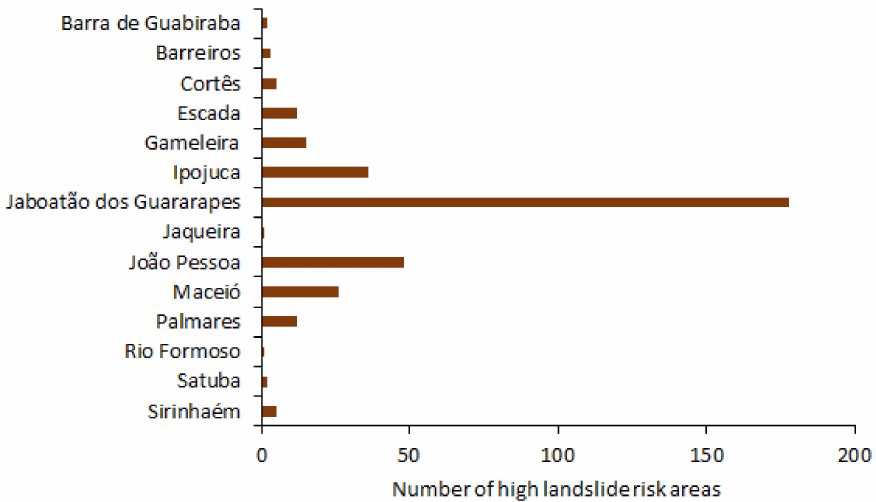
Figure 5. Number of high-risk sectors for landslides in municipalities located in